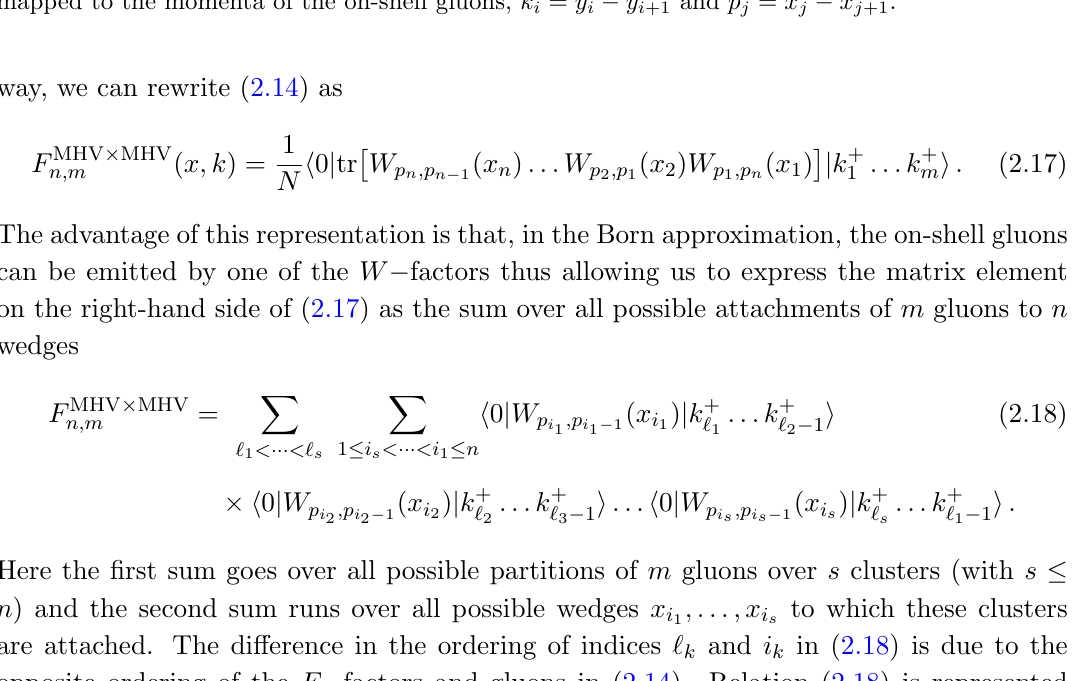
Figure 2 . Diagrammatic representation of the duality relation (2.25) for n = 6 and m = 5. Notice that the polygon vertices and the gluons are ordered in opposite directions. Black blobs with outgoing gluons denote wedge form factors (2.19). The lightlike edges of the Wilson loops are mapped to the momenta of the on-shell gluons, k i = y i − y i +1 and p j = x j − x j +1